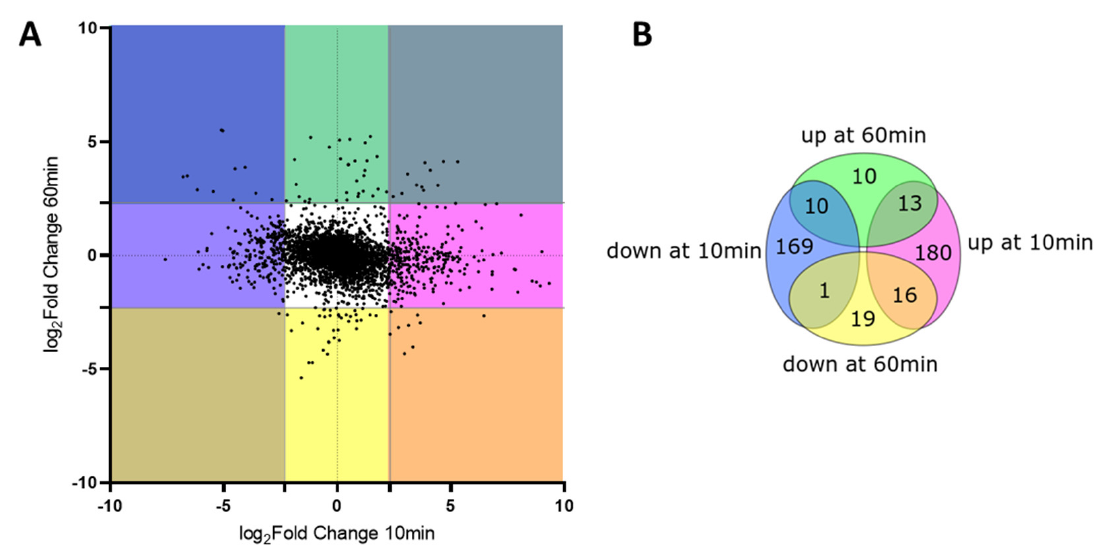
Figure 3. Comparison of transcriptomic changes at 10 and 60 min; ( A ) Each gene is represented by a black dot, x-axis: Fold Change (log 2 ) at 10 min (H 2 O 2 vs. untreated control), y-axis: Fold Change (log 2 ) at 60 min (H 2 O 2 vs. untreated control), pink: up-regulated at 10 min, blue: down-regulated at 10 min, green: up-regulated at 60 min, yellow: down-regulated at 60 min; ( B ) Venn diagram of conditions presented in A documenting the number of genes in each condition.